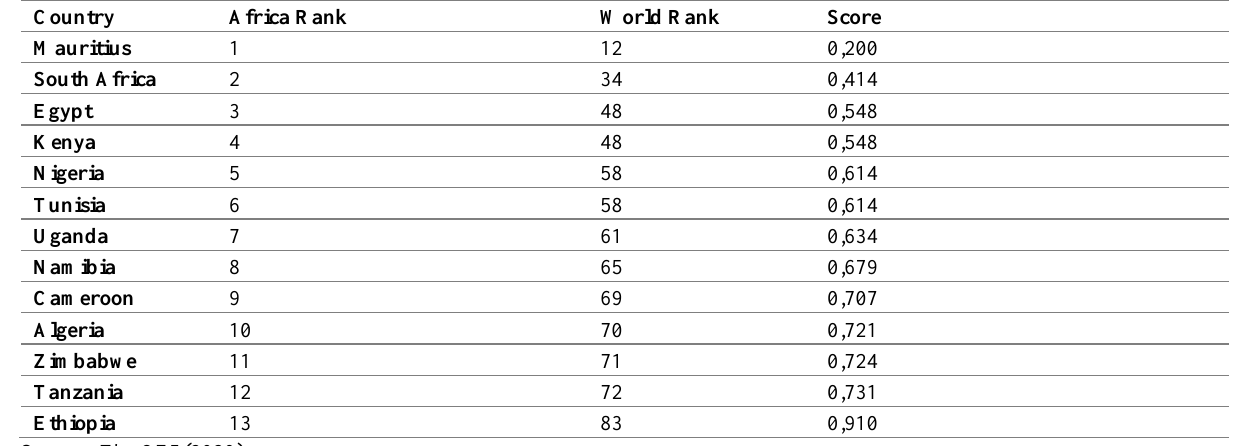
Table 3: Cybercrime Security Exposure Index ranking of African countries